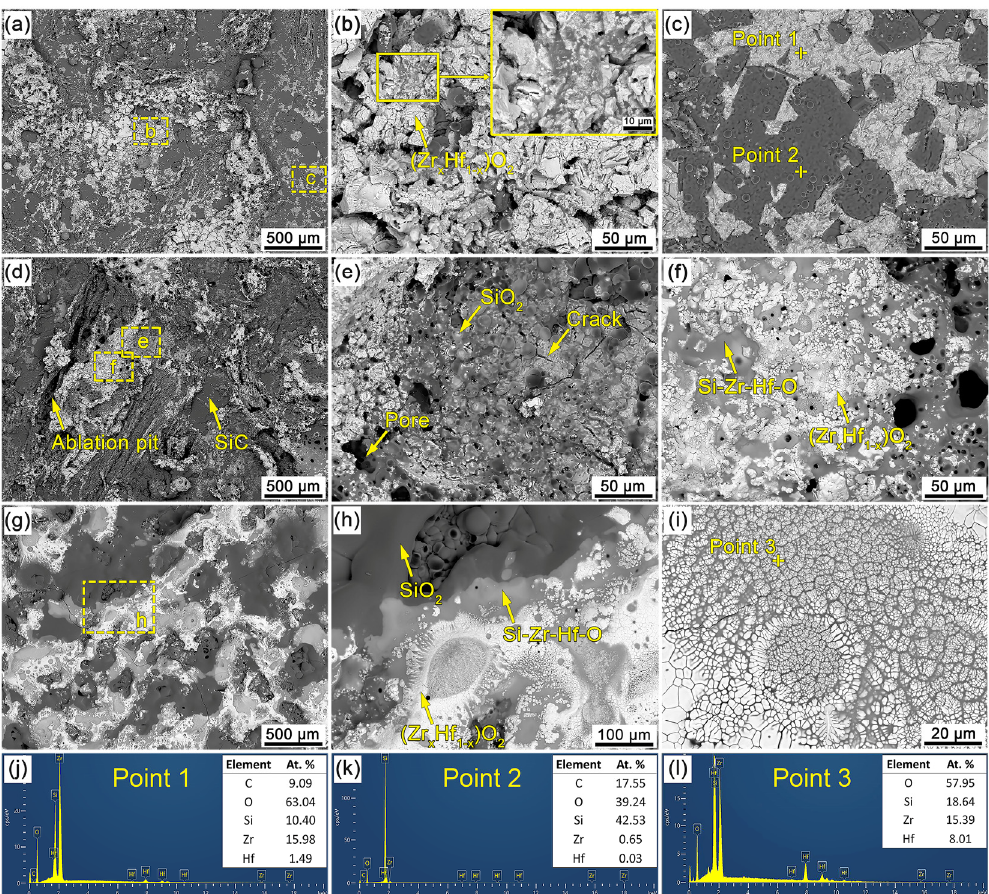
Figure 10. Surface SEM micrographs and EDS results of the C/C-SiC-(Zr x Hf 1 − x )C composites in the central region after ablation: ( a – c ) CMC-1; ( d – f ) CMC-2; ( g – i ) CMC-3; ( j – l ) EDS results.